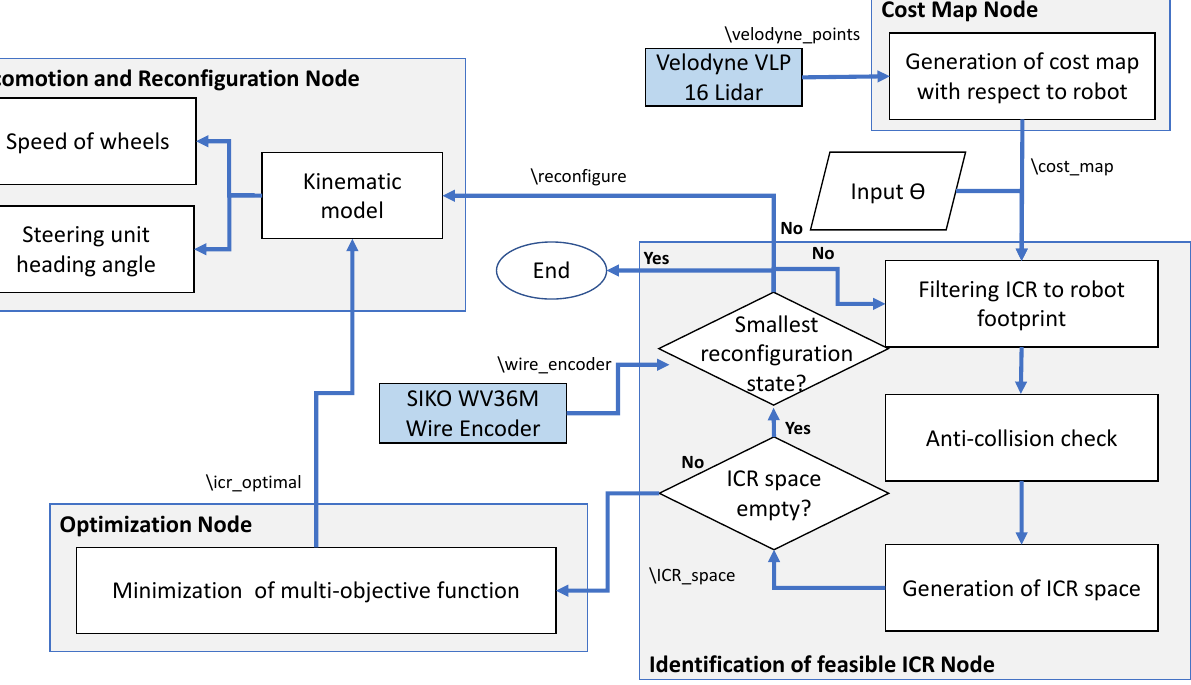
Figure 8. ROS nodes and topics developed for self-reconfigurable robot